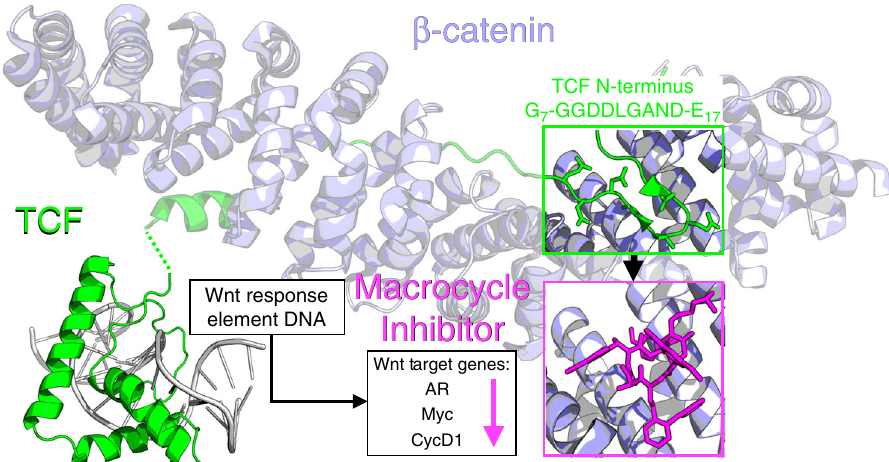
Fig. 1 Proposed mechanism for targeting β -Catenin. The designed macrocycles inhibit the interaction of the N-terminal region of TCF and β -Catenin resulting in a downregulation of AR (Androgen Receptor), Myc, and CycD1 (Cyclin-D1) 37,72 Crystal structures depicted are PDB 1G3J